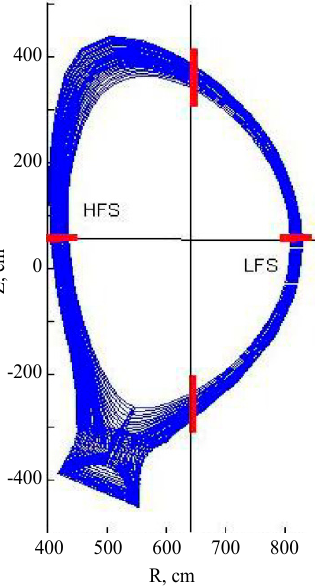
(SOL) in International Test Experimental Reactor (ITER) with designations of high field side (HFS) and low field side (LFS) domains